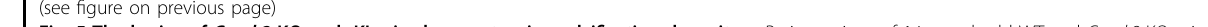
Fig. 5 The brains of Cmpk2 -KO and -KI mice have extensive calci fi cation deposits. a Brain sections of 14-month-old WT and Cmpk2 -KO mice were stained with H&E, Von Kossa, alizarin red, PAS, and Alcian blue. b Coronal and sagittal micro-CT scan of the brain of a Cmpk2 -KO mouse at 13 months. Arrowheads indicate the high-density foci (these are calci fi cation deposits). Ctx cortex, Crb cerebellum, Thal thalamus. c Progressive development of calci fi cation deposits in the brains of Cmpk2- KO mice at 10, 12, and 14 months. Calci fi cations are indicated by alizarin red and Von Kossa staining. d A gene diagram for the Cmpk2 -KI mouse model of the c.2 T > C mutation of the Cmpk2 gene. e Brain sections of 12-month-old Cmpk2 -KI mice were stained with H&E, Von Kossa, alizarin red, PAS, and Alcian blue. The calci fi cation volume is indicated at the left bottom of a series of continuous brain sections. Scale bar, 100 μ m in a , c , and e